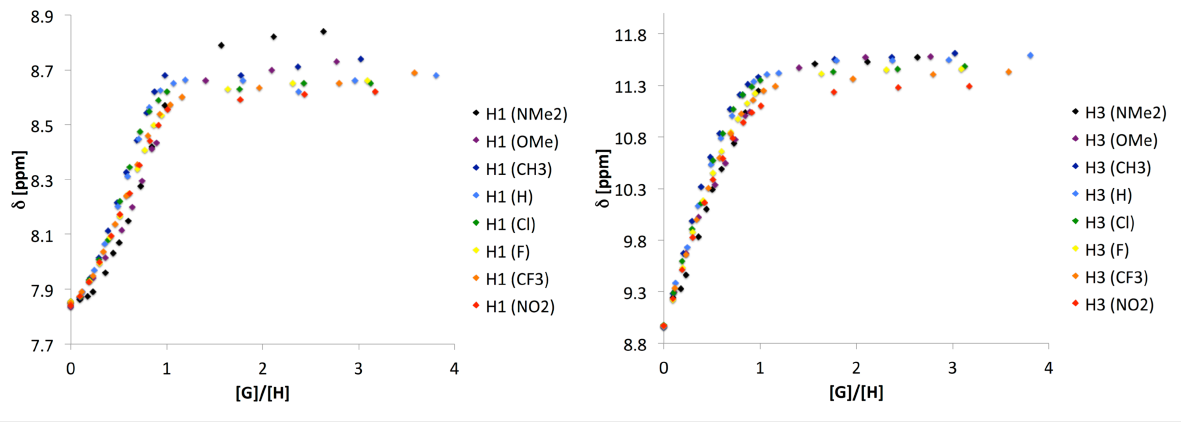
complex and this corresponds to the titration data from